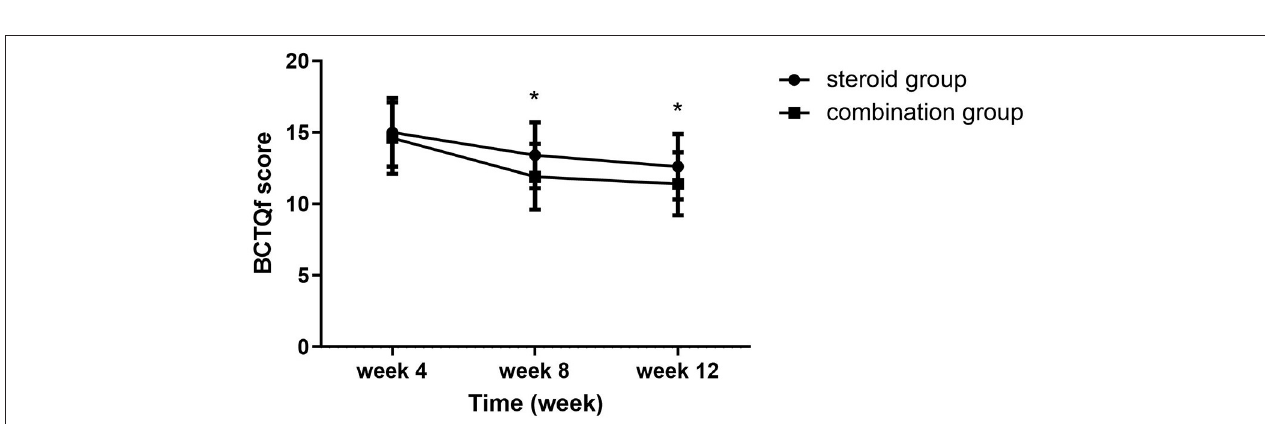
FIGURE 3 | BCTQs at 4-, 8-, and 12-week follow-up between the steroid and combination groups (mean ± SD). The differences were significant at weeks 8 and 12 (* P < 0.01, ANOVA with subsequent post-hoc Bonferroni test was used). BCTQ, Boston Carpal Tunnel Syndrome Questionnaire; s, severity.